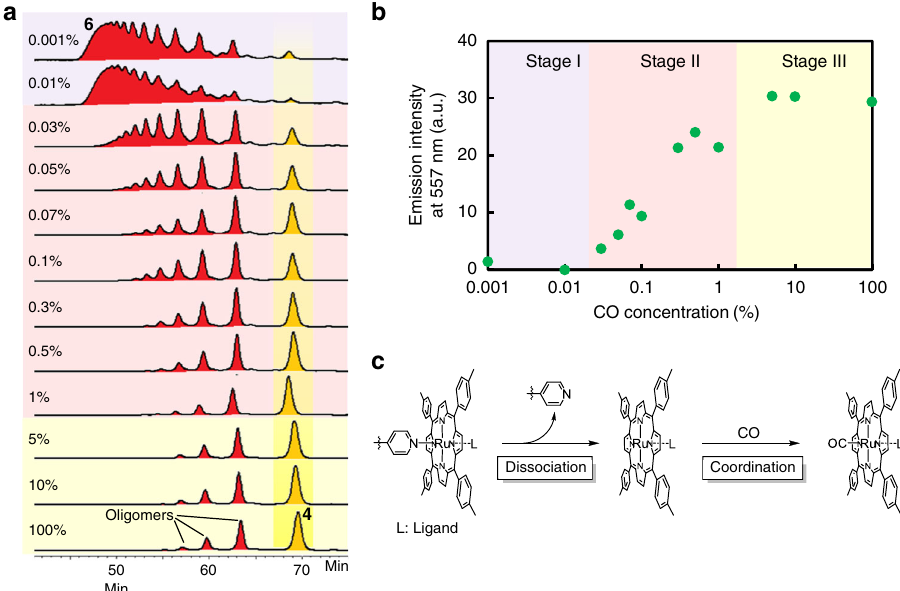
Fig. 4 Optical output with the dual self-controlling system. a SEC pro fi les (UV detector, 380 nm) and b concentration dependence of the emission intensities at 557 nm (deoxygenated condition, excitation at 365 nm) after reaction at 100 °C for 10 min with various concentrations of CO gas. c Ligand substitution reaction of the Ru(TTP)(L)Py complex with CO (Py: pyridine, L: